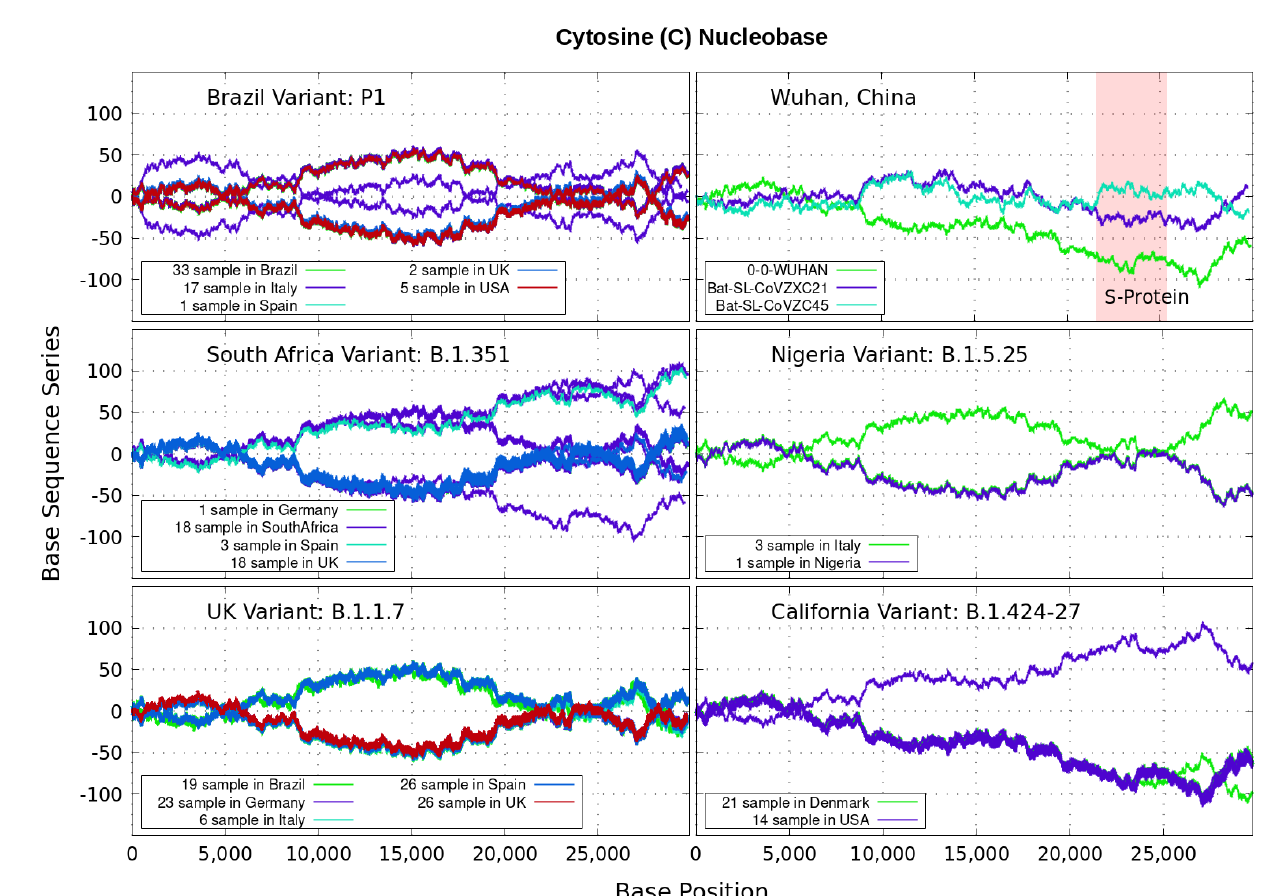
Figure 5. Variant imprints displayed by the nucleotide base: